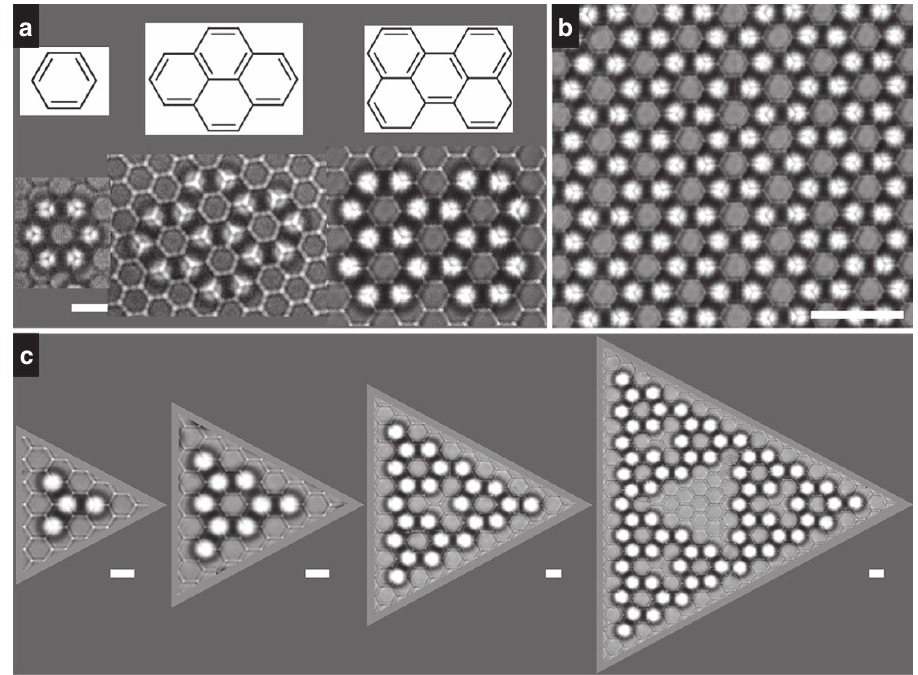
Figure 3 | Colloidal arene structures. ( a ) From left to right, colloidal benzene, pyrene and perylene. Scale bar, 3 m m. ( b ) Colloidene in analogy to graphene. Scale bar, 10 m m. ( c ) Four generations of a fractal honeycomb structure. Scale bar, 3 m